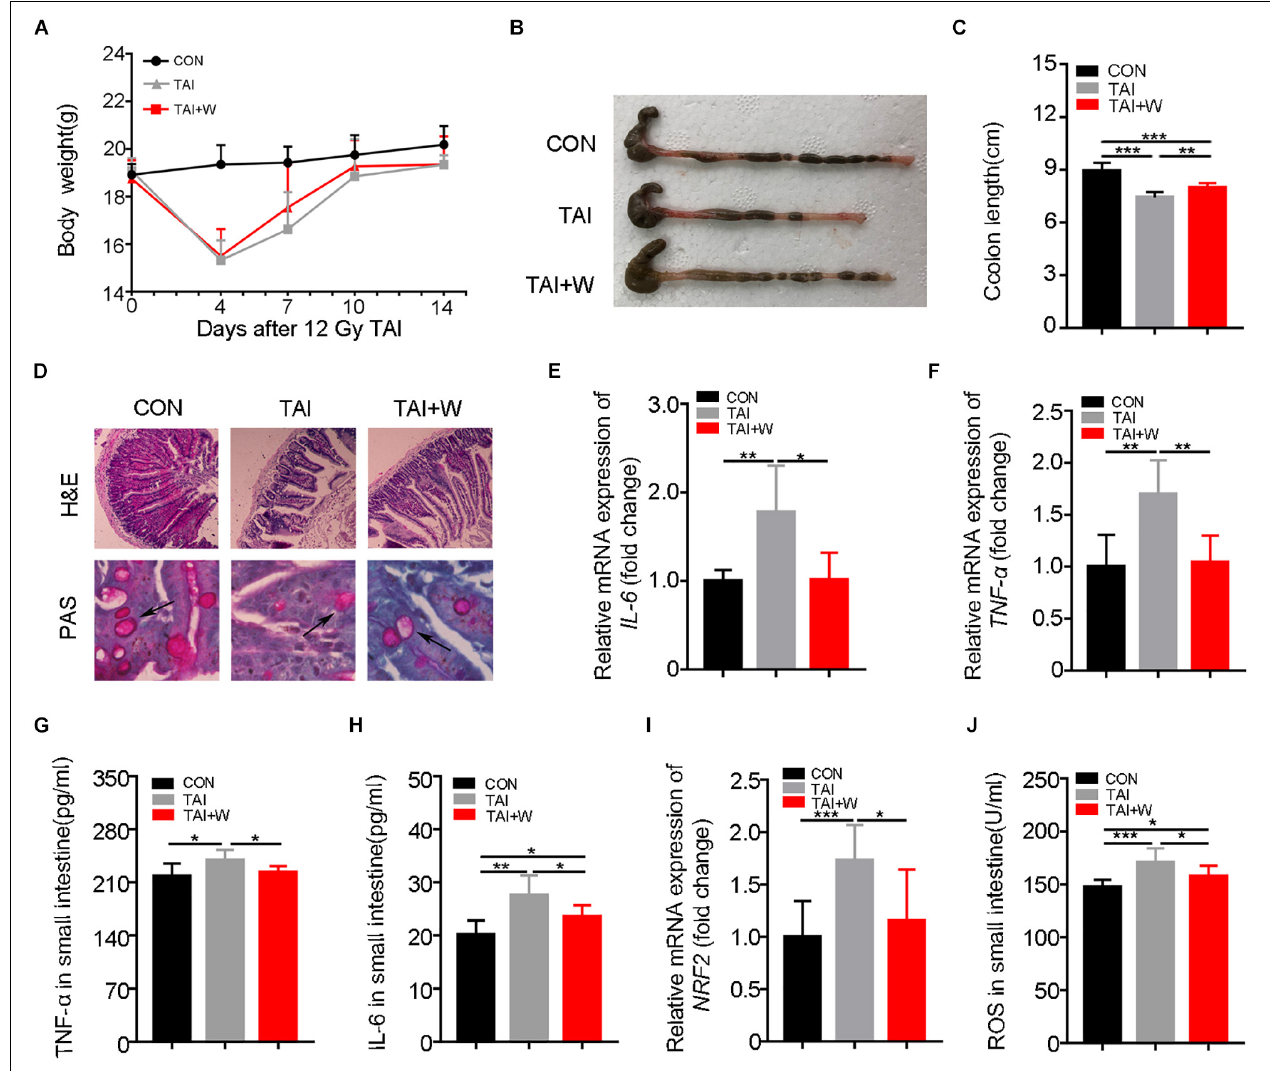
FIGURE 5 | Walking protects against radiation-induced GI tract toxicity in female mice. Except for female mice in Con group, female mice of the other two groups were exposed to 12 Gy of TAI, TAI + W group maintained walking for 15 days, and TAI group had no treatment. (A) The body weight of male mice in the three groups. (B) Photographs of dissected colon from male mice in the two groups. (C) Statistical results of colon length between two groups. (D) The morphology of the small intestine from male mice in the two groups was shown by H&E and PAS staining. The black arrows point to the goblet cells. (E–G) The expression levels of IL-6 , TNF- α , and NRF2 were examined in small intestine tissues from male mice by qRT-PCR. (H–J) The levels of IL-6, TNF- α , and ROS in the small intestine of male mice were measured by ELISA. Significant differences are indicated: * p < 0.05, ** p < 0.01, and *** p < 0.005 by Student’s t -test between two cohorts. GI, gastrointestinal; Con, control; TAI, total abdominal irradiation; W, walking; PAS, periodic